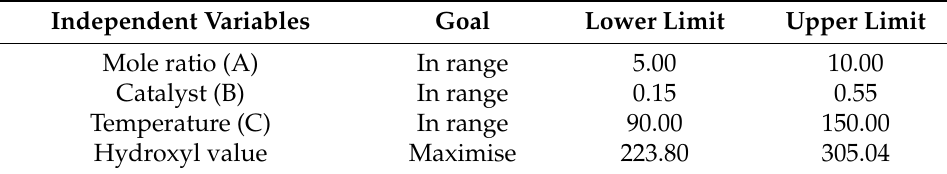
Table 4. Constraints applied for optimisation.